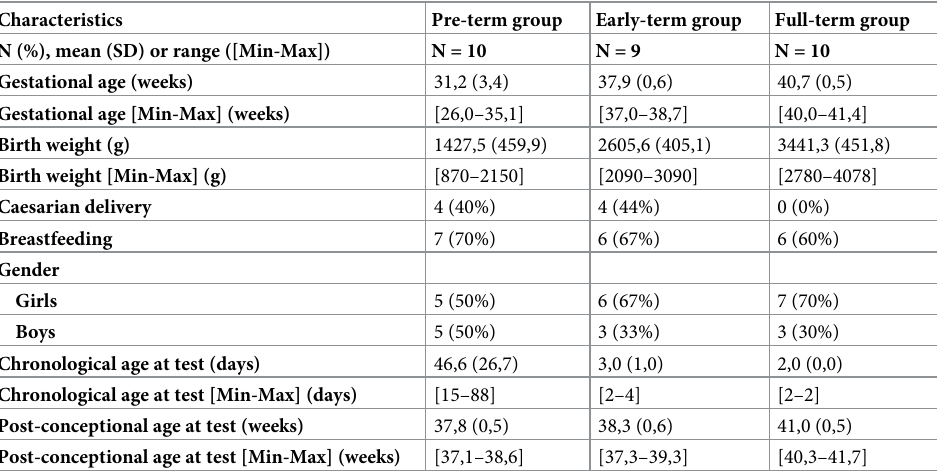
Table 1. Characteristics of the populations at birth and at time of